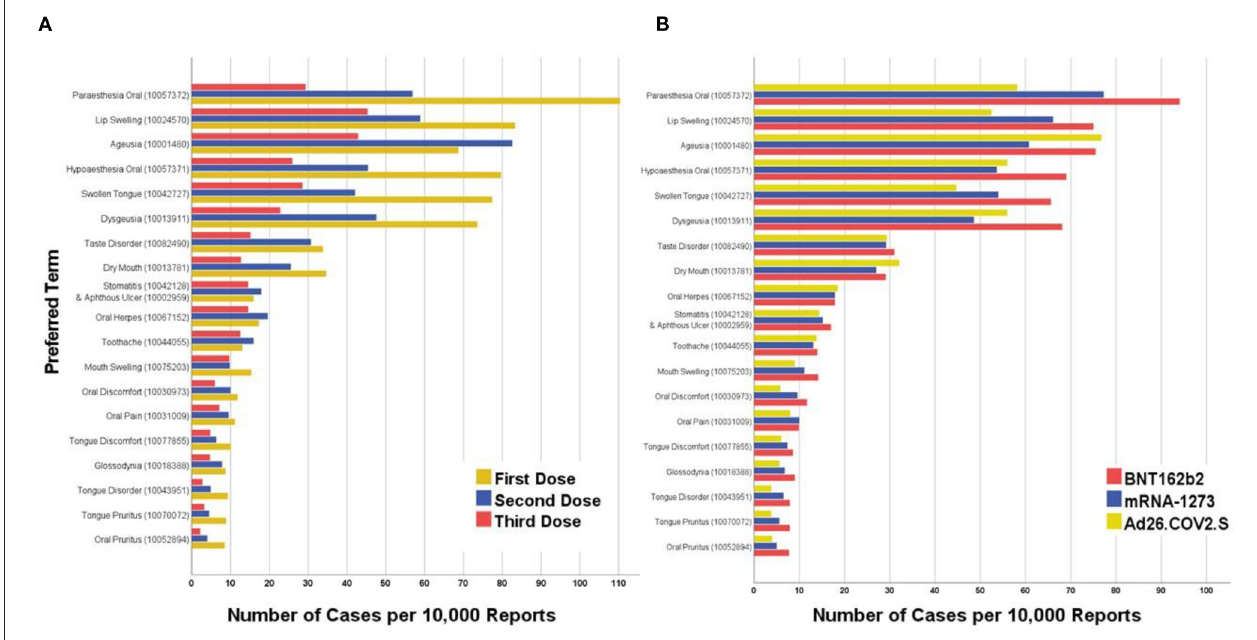
FIGURE 4 | Top twenty oral adverse events reported after COVID-19 vaccination in the United States stratified by (A) Dose and (B) Vaccine Brand, January–December 2021 (CDC; VAERS-WONDER).